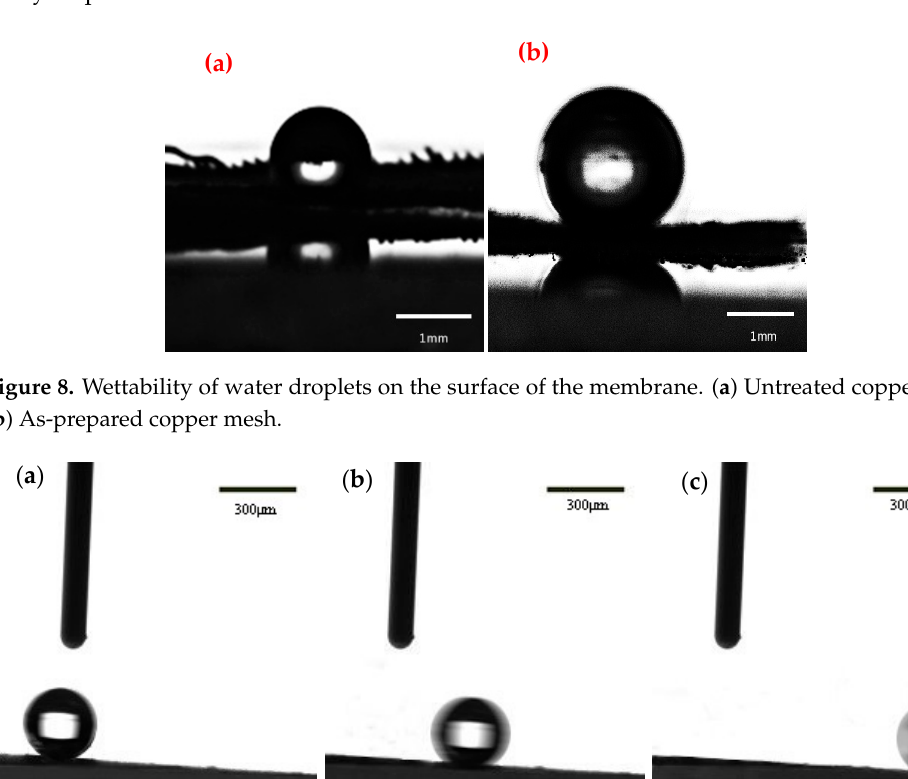
Figure 9. The diagram of water droplets (drop volume of 3 μ L) sliding on the surface of the as-prepared copper mesh. ( a ) The initial state of the water drops; ( b ) The rolling state of water droplets; ( c ) The rolling state of water droplets at the bottom of the slope.